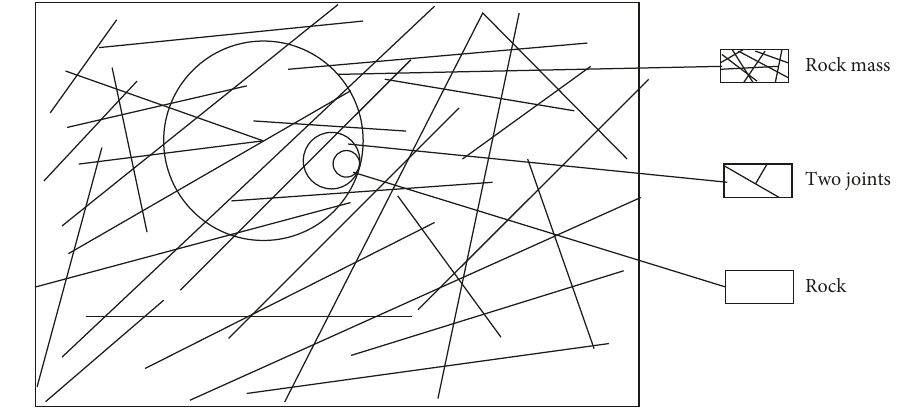
Figure 7: Size effects of rockmass.